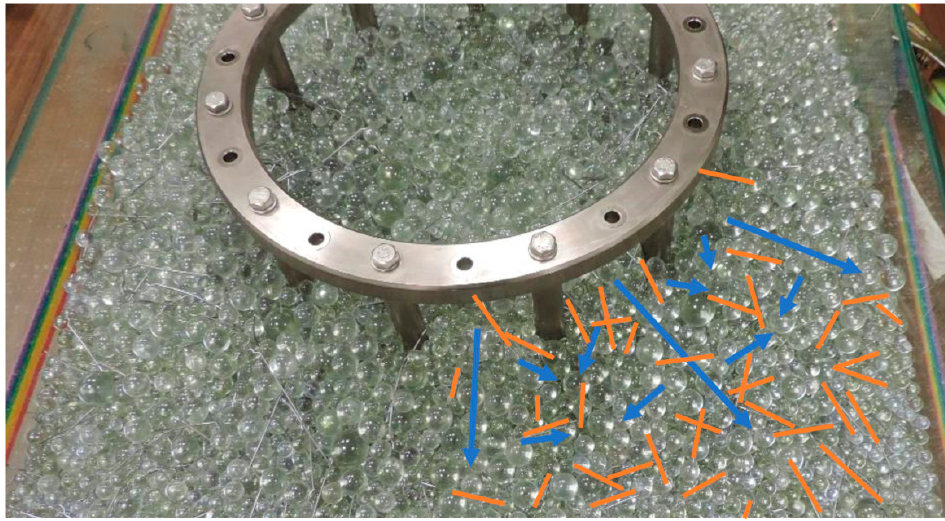
Figure 5. J-ring test monitoring the behaviour of the fibres during creep.